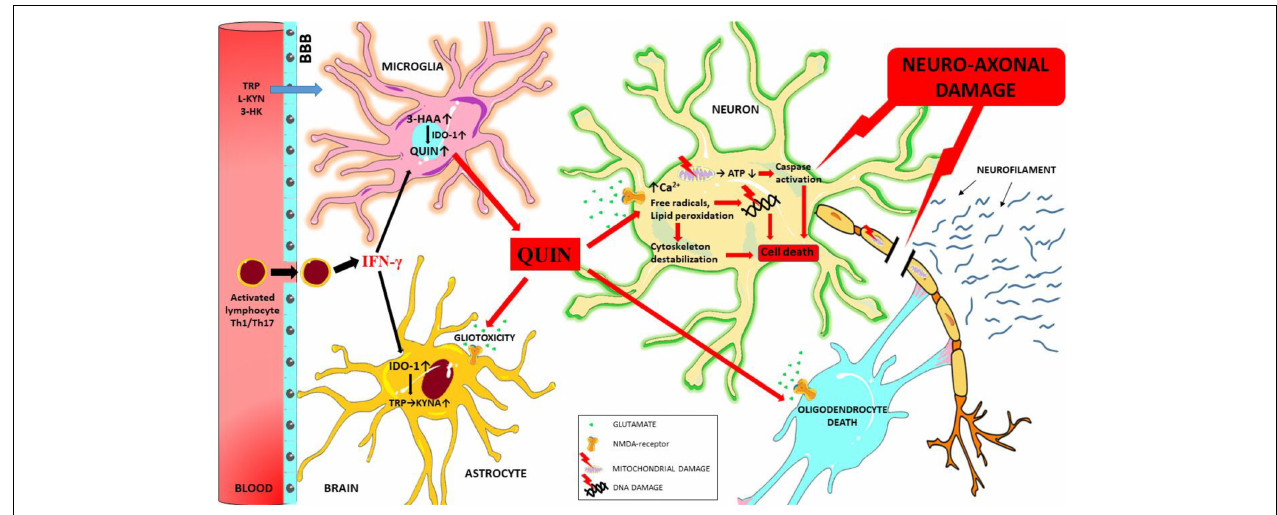
FIGURE 3 | Schematic overview of the mechanisms of QUIN toxicity in MS. During neuroinflammation autoreactive T cells (Th1 and Th17) and activated monocytes/macrophages migrate to the central nervous system through the damaged blood-brain barrier, and these cells secrete numerous pro-inflammatory cytokines (such as interferon gamma). Interferon gamma is one of the most potent activators of IDO-1, the primary enzyme of the KP. In case of an enzymatic imbalance in the KP and also through the chronic alteration of the physiological concentration of kynurenine metabolites in the microenvironment the balance between neuroprotective and neurotoxic processes is no longer ensured. Neurotoxic QUIN secreted in abnormal quantities by activated macrophages and microglia cells in an inflammatory microenvironment can damage oligodendrocytes, astrocytes and neuron through multiple mechanisms. QUIN induces caspase activation, mitochondrial impairment, oxidative stress, lipid peroxidation and energy deficit through the overactivation of NMDA receptors (and also independently of overactivation). These factors combine to result in the destabilization of the cytoskeleton, leading to DNA damage, cell death and ultimately neuro-axonal damage. Neurofilaments are released as a result of neuro-axonal injury. 3-HAA, 3-hydroxyantranilic acid; 3-HK, 3-hydroxykynurenine; ATP, adenosine triphosphate; BBB, blood-brain barrier; IFN- γ , interferon gamma; IDO-1, indoleamine 2,3-dioxygenase; L -KYN, L -kynurenine; KYNA, kynurenic acid; QUIN, quinolinic acid; TRP,